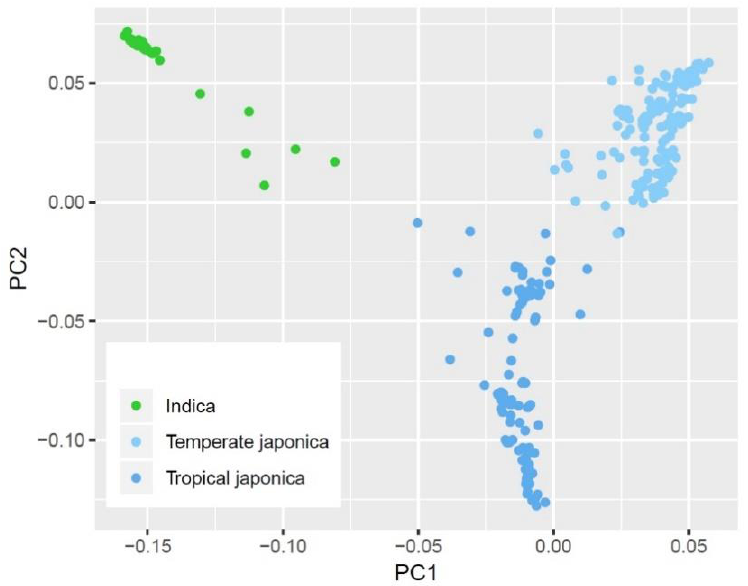
Figure 3. Principal component analysis showing genetic variation between indica (green), temperate japonica (light blue), and tropical japonica (dark